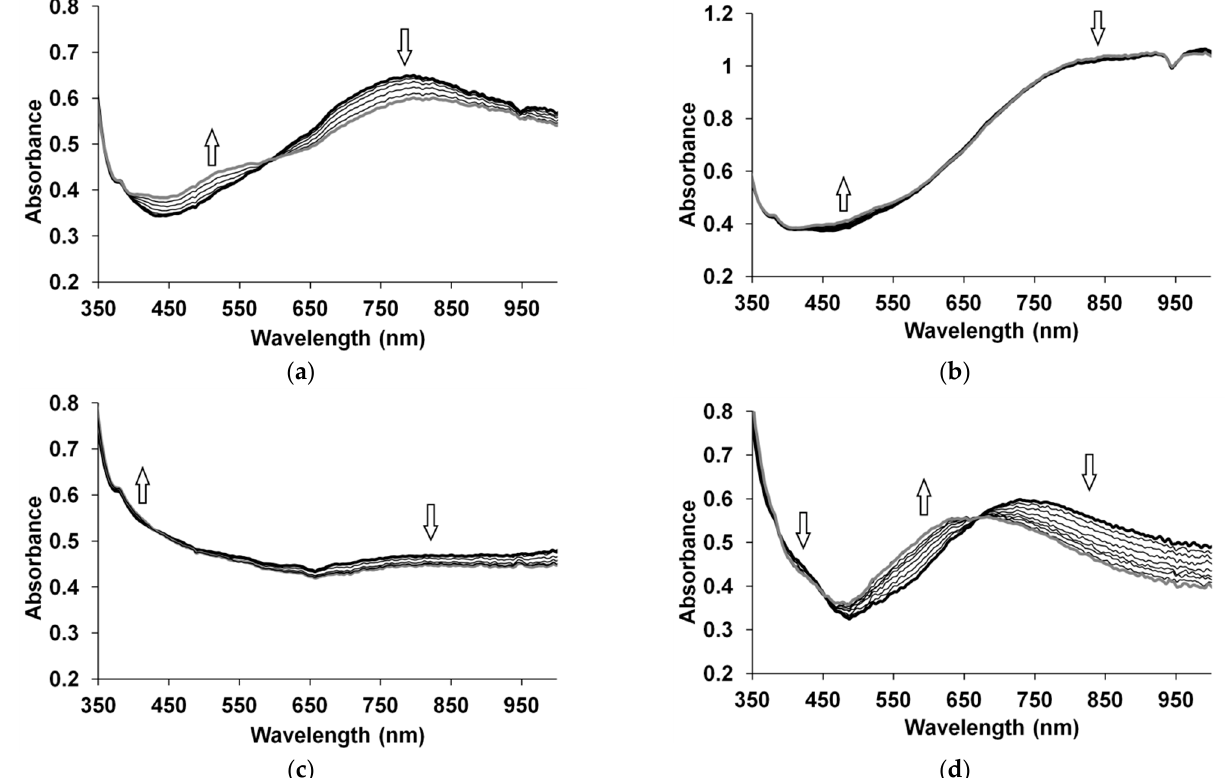
Figure 2. Evolution of UV-visible NIR absorption spectra of PEDOT-i-PASA ( a ), PEDOT-PSSA ( b ), PPy-i-PASA ( c ) and PANI-PAMPSA ( d ) exposed to 52 ppm NH 3 . Up (down) arrows indicate simultaneous growth (reduction) of absorbance at characteristic wavelengths during an 800 s exposure to ammonia vapor.